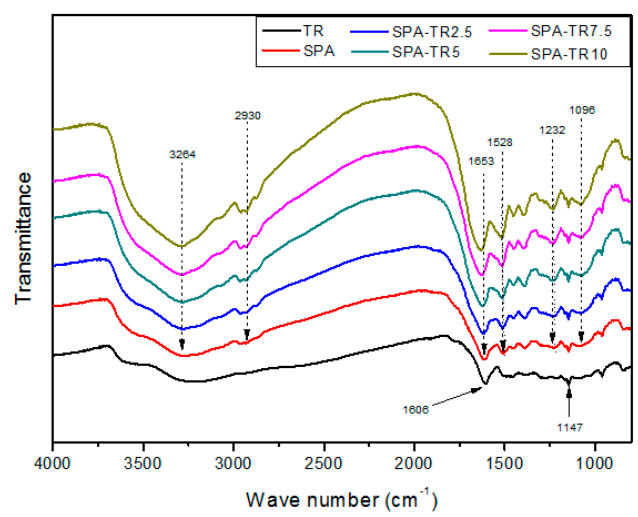
Figure 3. FTIR spectra of different adhesives.